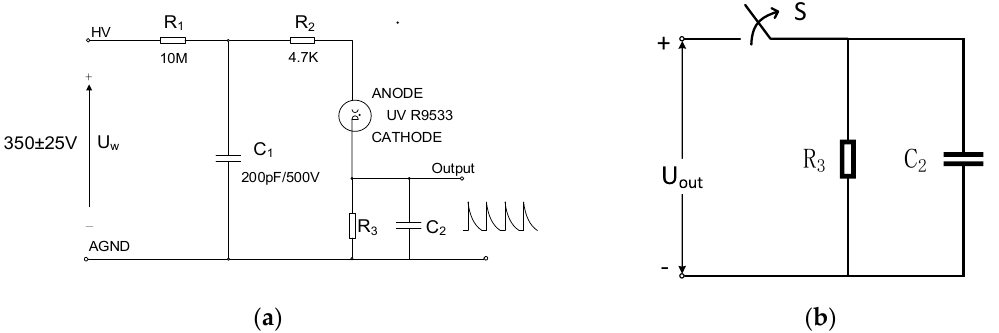
Figure 2. UVTRON drive circuit. ( a ) Recommended operating circuit. ( b ) The equivalent circuit on the output side.